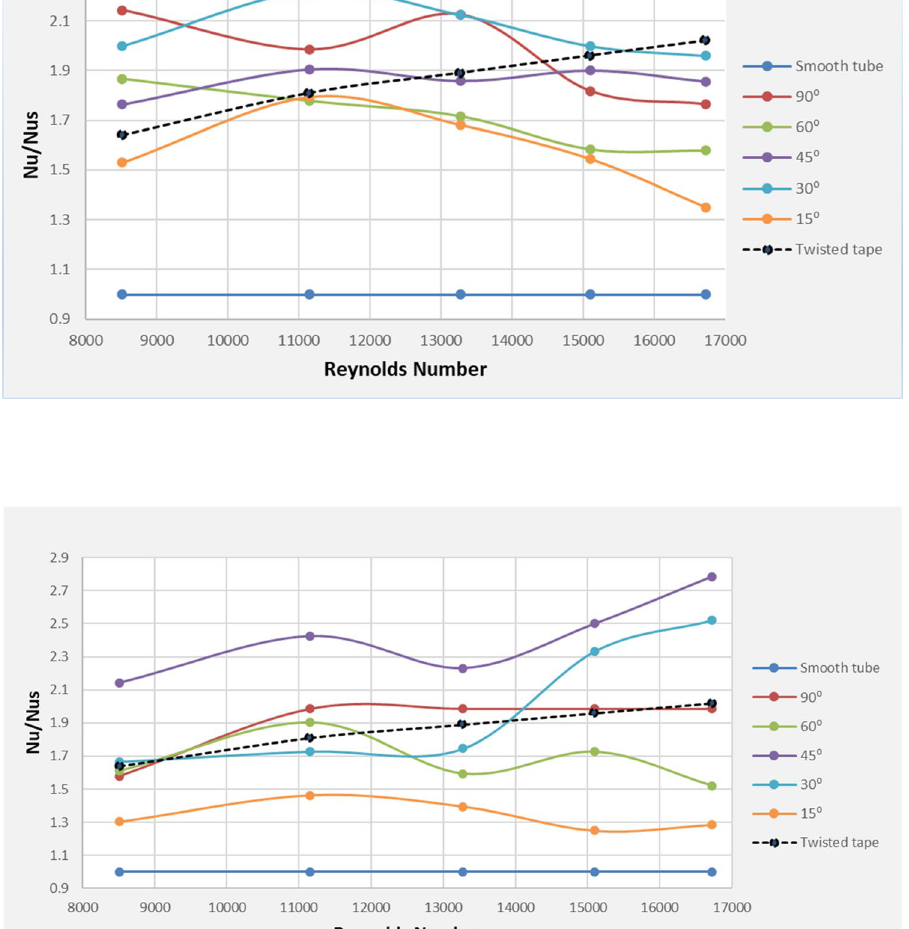
Fig. 11 Variation of Nu/Nus with Reynolds Number at P/D = 3 for MIs and Twisted tape